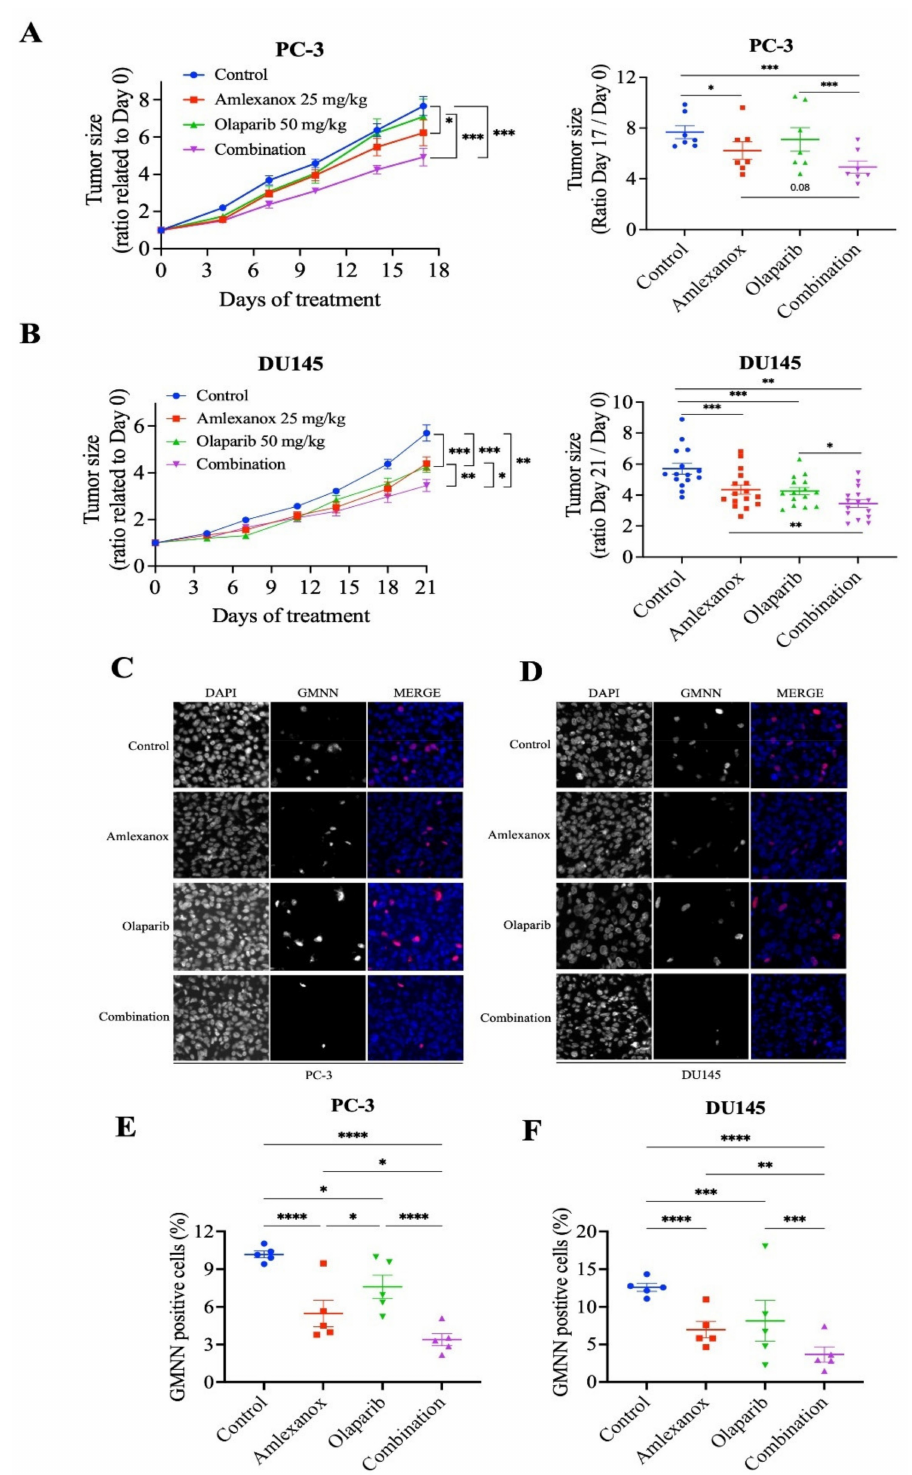
Figure 6. Amlexanox-Olaparib combination delays CRPC xenograft tumor growth in mouse model. ( A , B ) Tumor size ratio between the first and last days of treatment for PC-3 and DU145 xenograft tumors ( n = 9 and n = 18, respectively). Amlexanox (25 mg/kg) and/or Olaparib (50 mg/kg) were administered daily by intraperitoneal injection. Tumor size was measured twice a week and all mice were sacrificed at endpoint. ( C – F ) Representative images ( C , D ) and quantification ( E , F ) of percentage of GMNN-positive cells (red) in PC-3 ( C , E ) and DU145 ( D , F ) xenografts ( n = 5 per condition). Statistical significance was determined by two-way ANOVA. * p < 0.05; ** p < 0.01; *** p < 0.001; **** p <